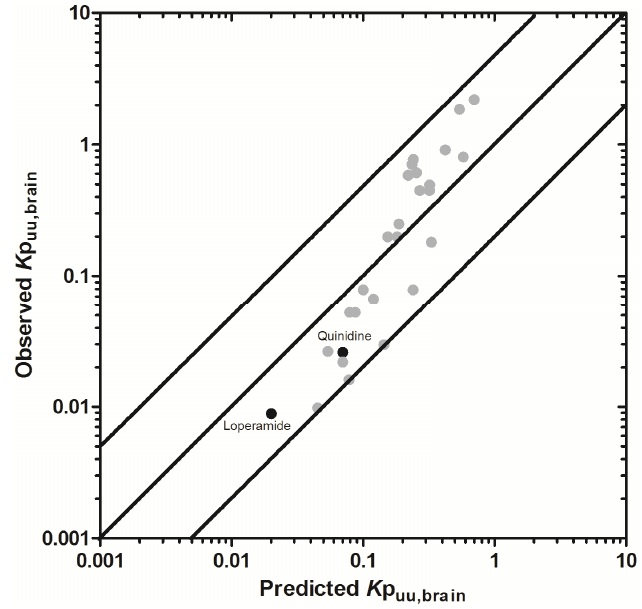
S6. Simulated K p and CSF :P for Loperamide and Quinidine uu,brain u u model predictions for loperamide and quinidine (highlighted in black) Figure S3. K p uu,brain using an in vivo surrogate efflux ratio metric for highly effluxed transporter